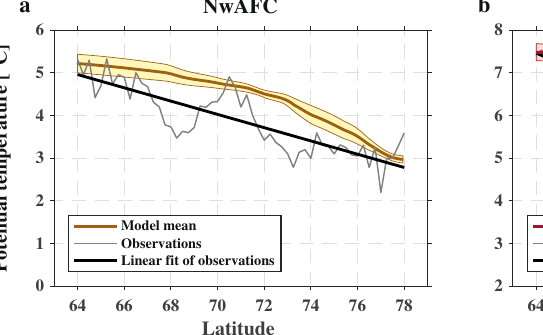
respectively, withthestandard errorshaded.The observed temperaturechangeof Atlantic Water and a linear fi t of thischange are shown by the grayand black lines, respectively. The netcooling of AtlanticWater along the entire current is shownin Supplementary Table 2.